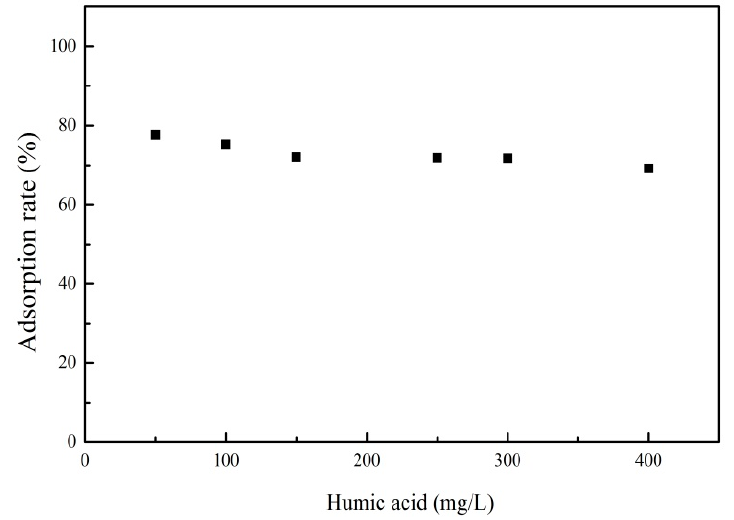
Figure 9. The effect of humic acid on the adsorption of PRO onto ATP/Fe 3 O 4 /GO.